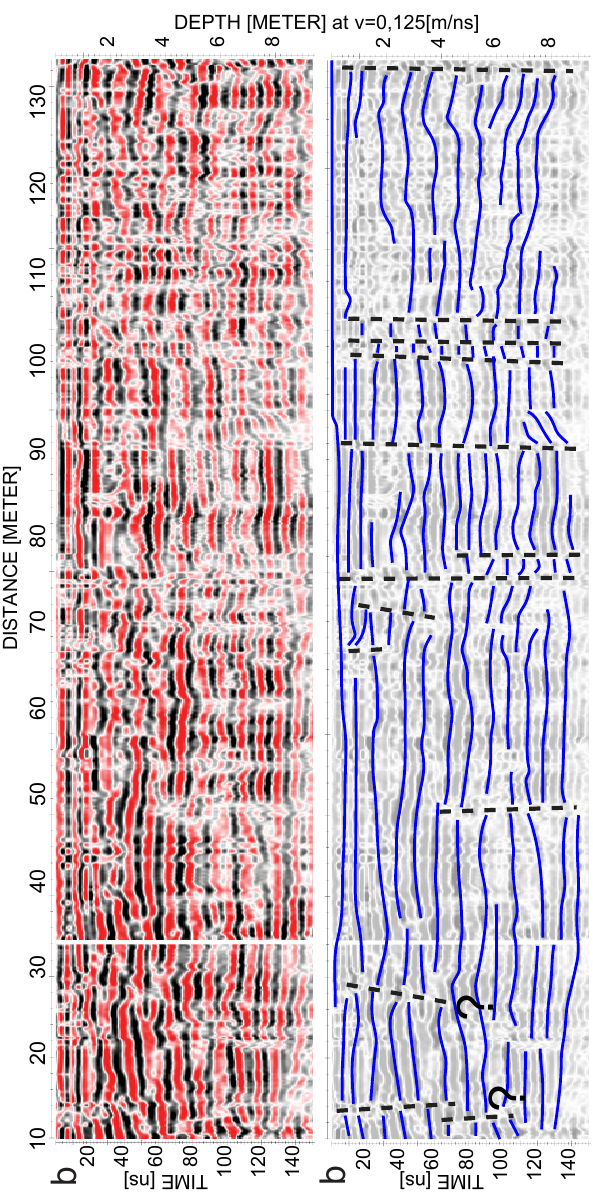
Figure 10. Radargram (a) and interpretation (b) of the WNW–ESE (red line) profile crossing through Devil’s Lane of the 100MHz an- tenna. Blue lines show interpreted reflectors; dashed lines represent interpreted faults. In general the profile is similar to the 400MHz profile. The locations of major faults coincide.